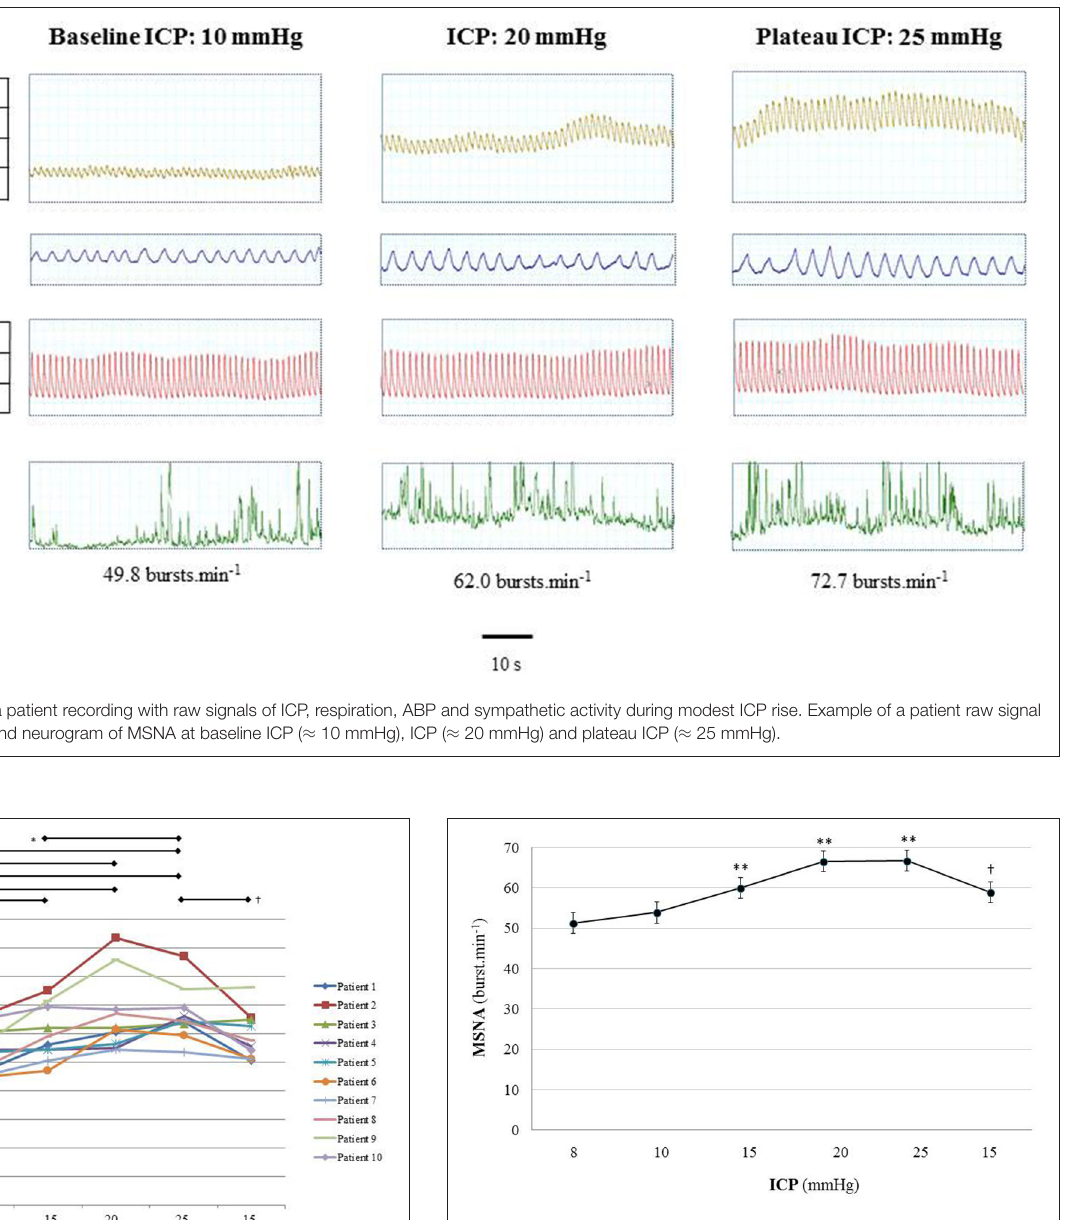
FIGURE 7 | Graph of MSNA changes during modest ICP increase and decrease in human ( n = 10). Mean ± sem values of MSNA values at various ICP levels. Statistical analysis was performed using ANOVA for repeated measures with Tukey’s post-test. ** p < 0.01 vs. baseline and † p < 0.05 vs.